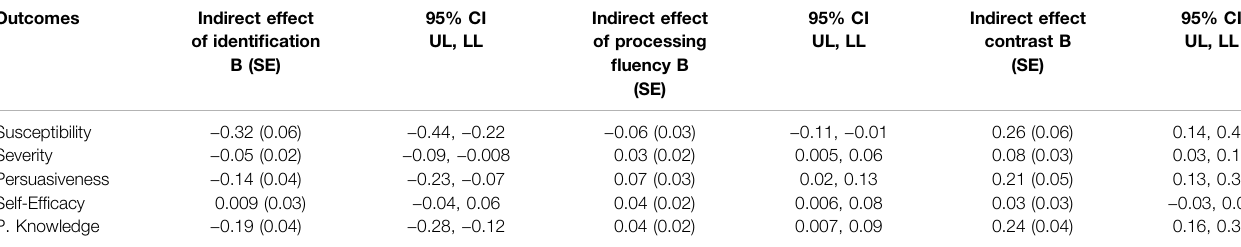
Note: The fi rsttwocolumnsdenotetheindirecteffectofnarrativeformatonoutcomesthroughidenti fi cationandtheassociated95%con fi denceintervalforthisparameter.Thesecondtwo columns denote the indirect effect of narrative format on outcomes through processing fl uency and the associated 95% con fi dence interval for this parameter. The last two columns provideacontrastofparameterestimates.Theestimatefortheeffectofidenti fi cationissubtractedfromtheestimateoftheeffectforprocessing fl uency.Apositivecoef fi cientindicatesthat processing fl uency produced the larger effect. All models were run using Model 4 (Hayes, 2013, 95% bias-corrected bootstrap CIs based on 10,000 resamples) with the “ contrast (cid:1) 1